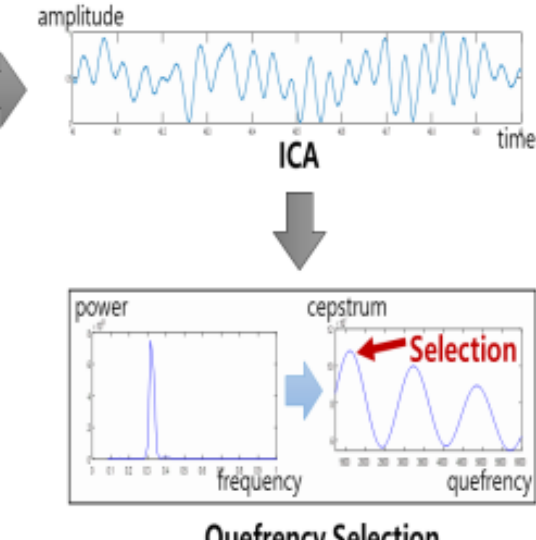
Figure 4. Diagram for respiration rate estimation. ICA: independent component